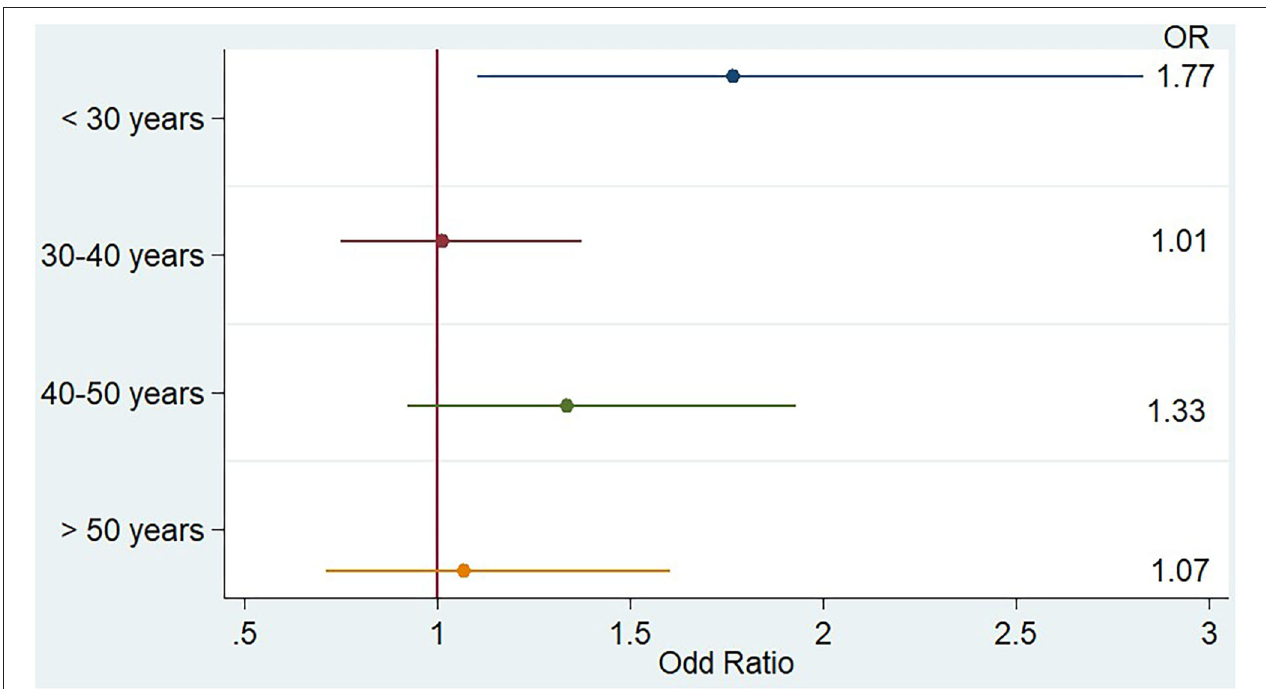
FIGURE 3 | Impact of PM 2.5 weekly concentration during week[-3] on the risk of multiple sclerosis relapse stratified by age, multivariate